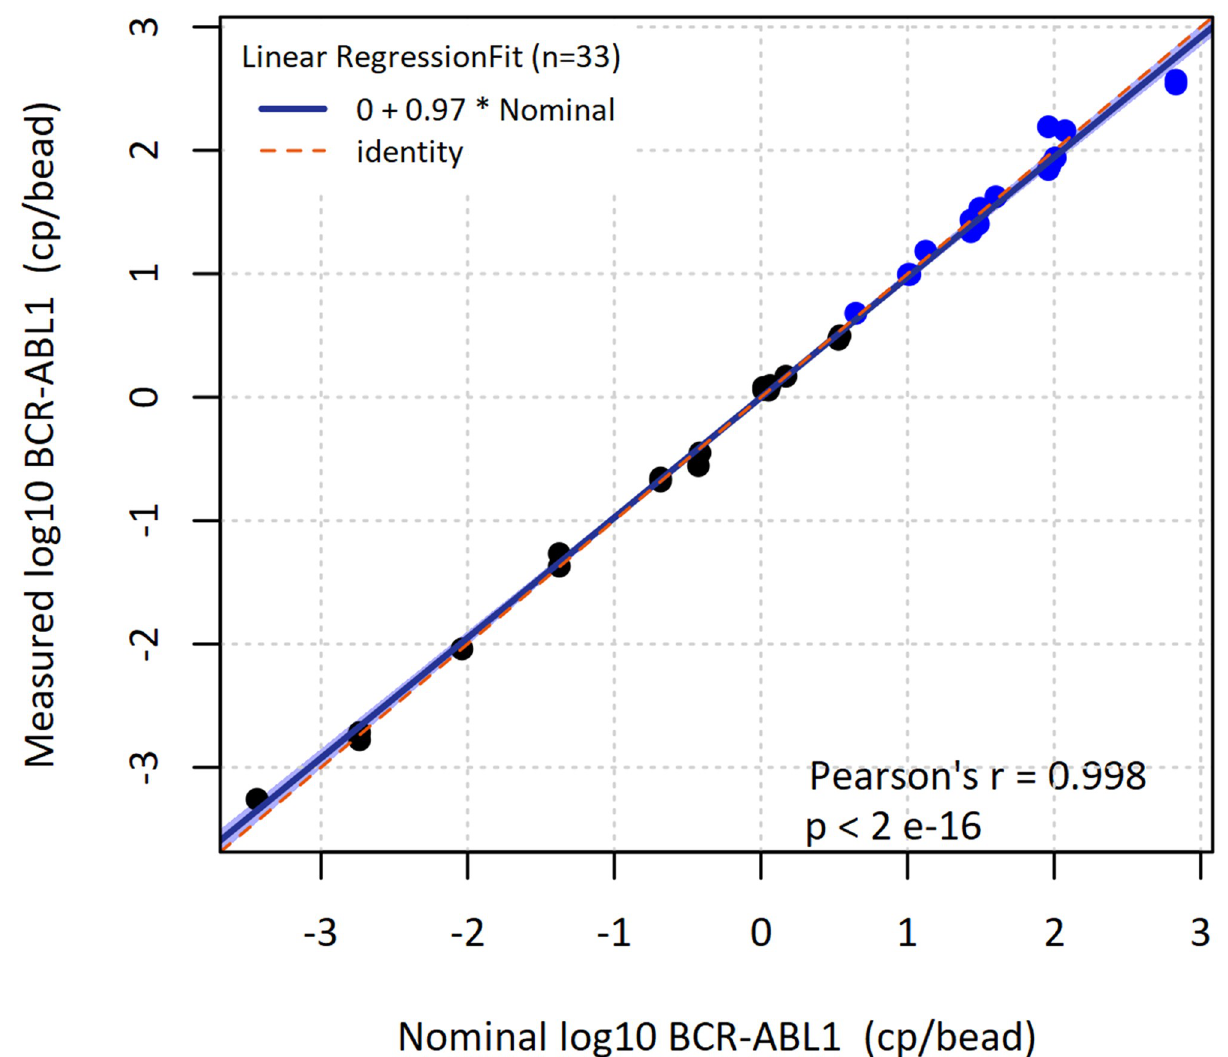
Fig 6. BCR-ABL1 measuring range. Input copies per bead are plotted on the x-axis against the measured copies per bead on the y-axis (both logarithmic scale; black, Poisson analysis of digital PCR data; blue, Ct-value analysis of quantitative real-time